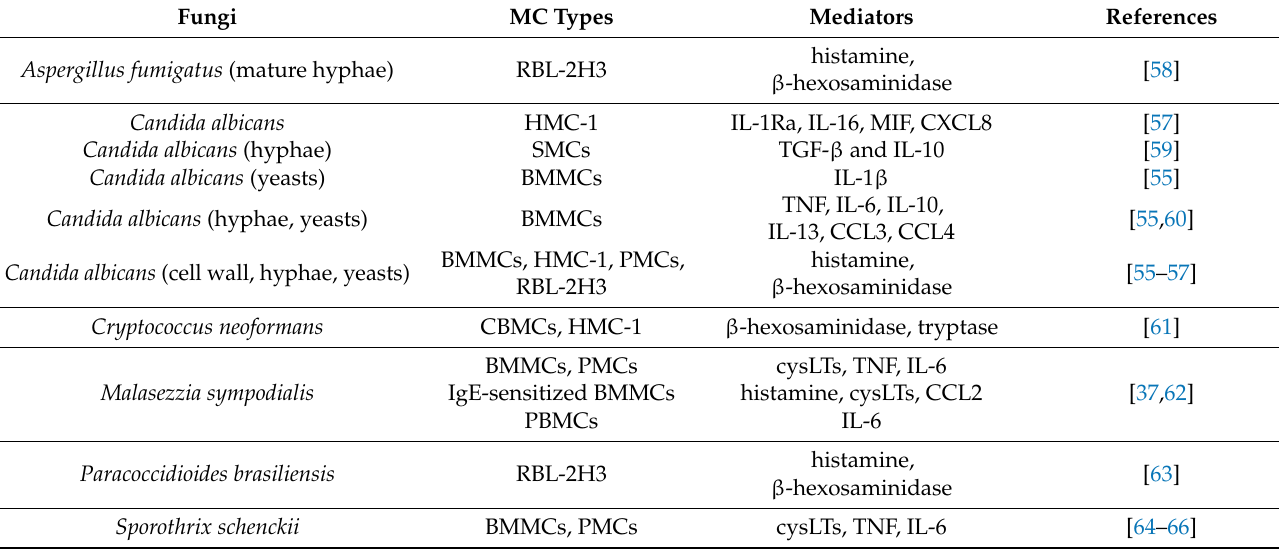
Table 1. The influence of fungi or their cells on MC mediator